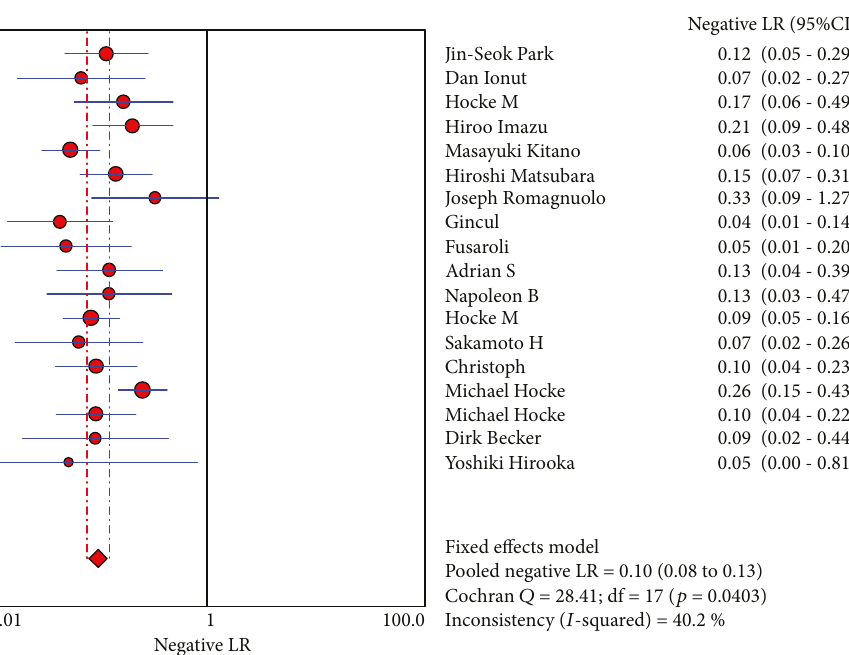
Figure 6: Negative LR of the selected studies and this